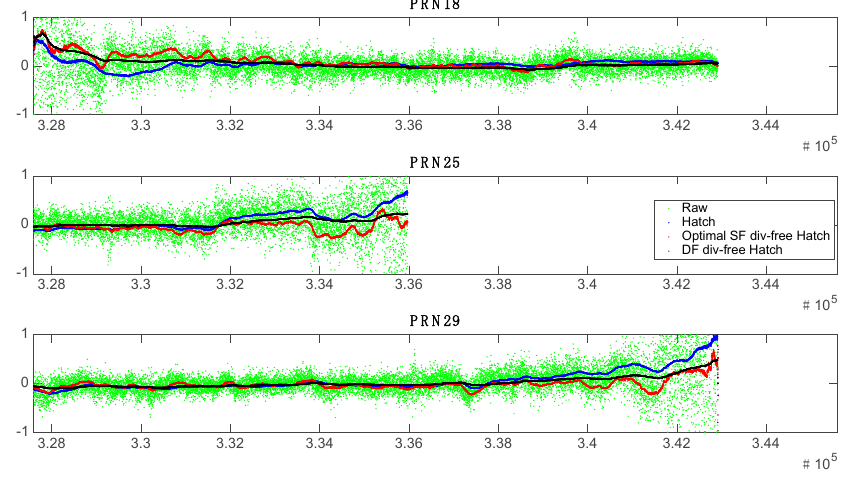
Figure 13. Residual error in range-domain for PRN #18, 25, and 29.